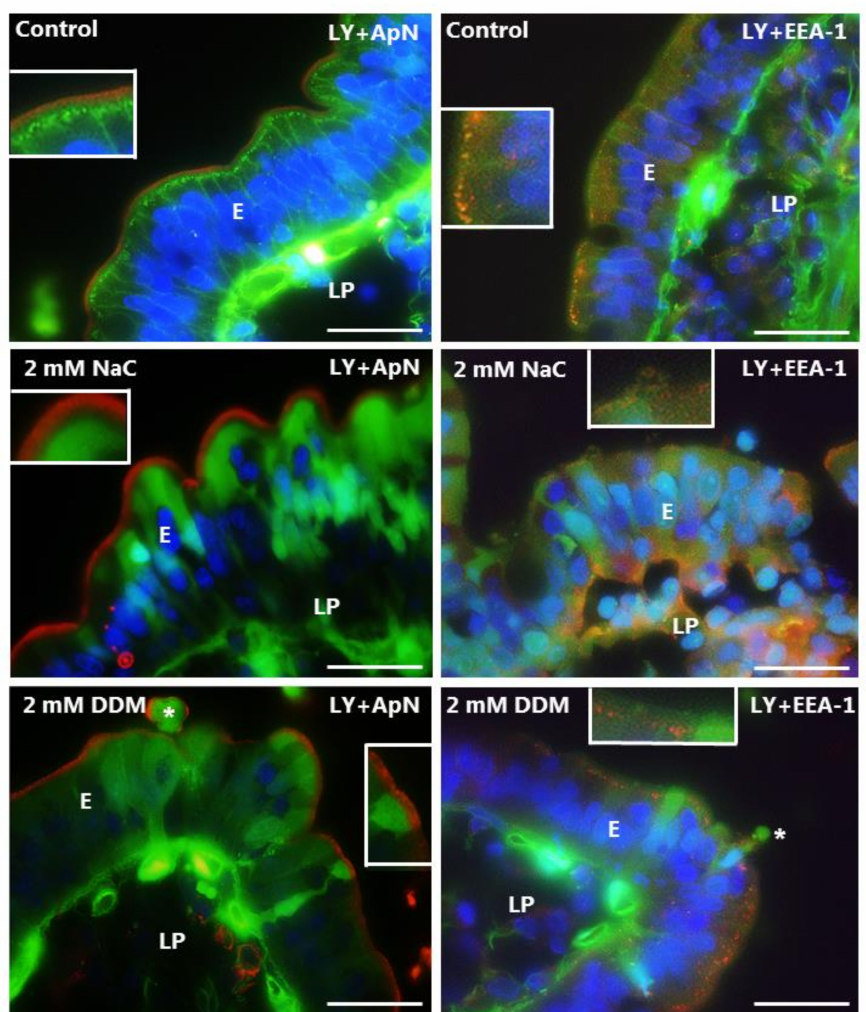
Figure 5. Permeability of the mucosal epithelium probed with LY at 2 mM concentration of PEs. Sections of mucosal explants cultured for 1 h with LY in the absence or presence of 2 mM NaC or DDM, respectively. In addition, the sections were immunolabeled for ApN, a brush border enzyme, or for EEA-1, a marker for early endosomes. In the controls, a string of EEA-1-positive subapical punctae shows uptake of LY into apical early endosomes of the enterocytes, whereas the cytosol is only weakly labeled. Lateral labeling and strong staining of the lamina propria are also seen, indicating a paracellular passage of LY through the tight junctions. At 2 mM, both NaC and DDM frequently caused LY to enter the enterocyte cytosol, indicating a leakage through the cell membrane, but endocytic uptake was not observed. Asterisks indicate enterocytes in the process of exfoliation. Inserts show enlarged image details. Bars: 20 µ